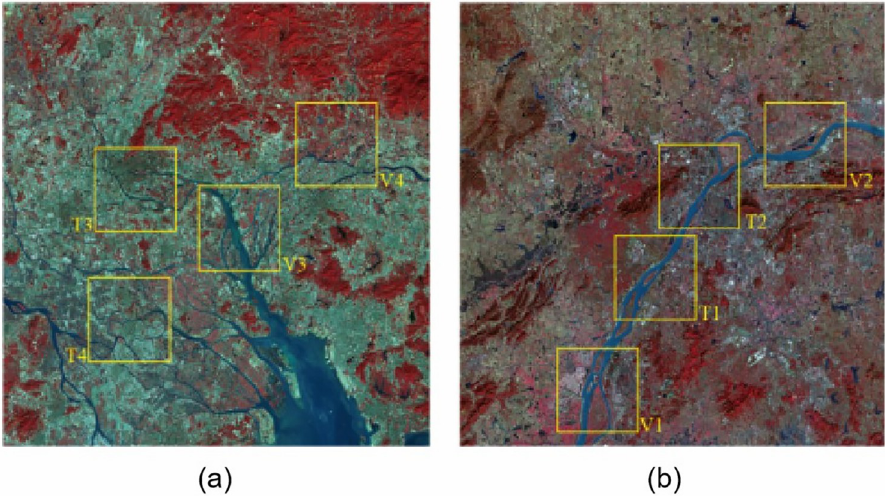
Fig 4. Images of the Yangtze River basin and the Pearl River Delta region. The picture shows the remote sensing images of (a)Nanjing and (b)Guangzhou, China, processed by standard false-color synthesis, where regions T1-T4 and V1-V4 are divided into training sets and test sets, respectively. Reprinted from www.gscloud.cn under a CC BY license, with permission from Dr. Qinghui Lin, original copyright 2019.